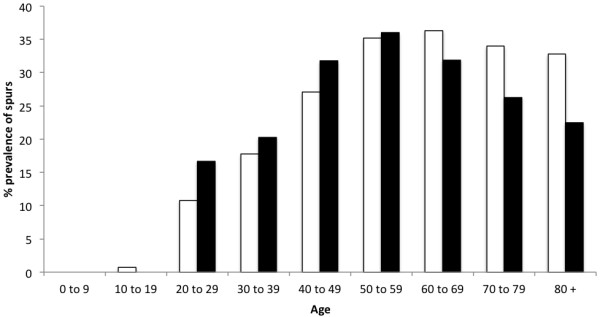
The prevalence of Achilles spurs in men and women by age category. Note that the prevalence of Achilles spurs were significantly higher for women (black bars) than men (white bars) in individuals <49 years of age. However, Achilles spurs were more common in men than women after 60 years old.